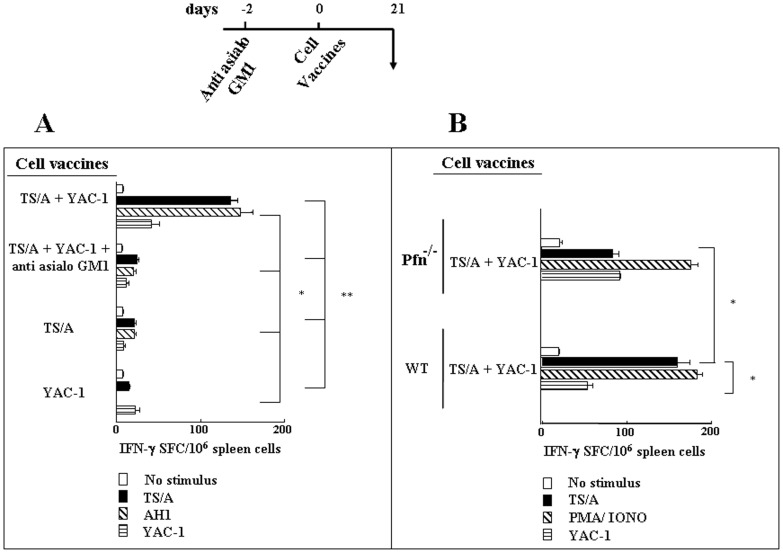
DC editing by NK cells promotes antigen specific CTL expansion.A: Mice were inoculated with immunogenic TS/A cells, TS/A cells mixed with MHC-devoid cells (YAC-1) or YAC-1 cells alone. In a group of mice, anti-asialo GM1 mAbs were administered i.p. 48 h before administration of cell vaccines to deplete NK cells. After 21 days, splenocytes were restimulated with either TS/A cells, the TS/A MHC class I-restricted immunodominant peptide AH1 or with YAC-1 cells and the frequencies of IFNγ-producing cells were determined by ELISPOT assay. A significant increase of antigen-specific IFNγ-producing cells was detectable in mice vaccinated with TS/A mixed with YAC-1 cells (TS/A + YAC-1). The increase in antigen-specific CTL was abrogated when mice had been depleted of NK cells before vaccination (TS/A + YAC-1 + anti asialo GM1). B: Similar experiments were performed in perforin KO mice (pfn −/−) and in parallel with wild type (WT) mice. A significant lower number of TS/A tumor-specific CTL was induced by vaccination in perforin KO mice when compared to wild type mice. Bars represent mean values and SEM of results obtained in three independent experiments (three mice per group). ** =  p < 0,001; * =  p < 0,005.